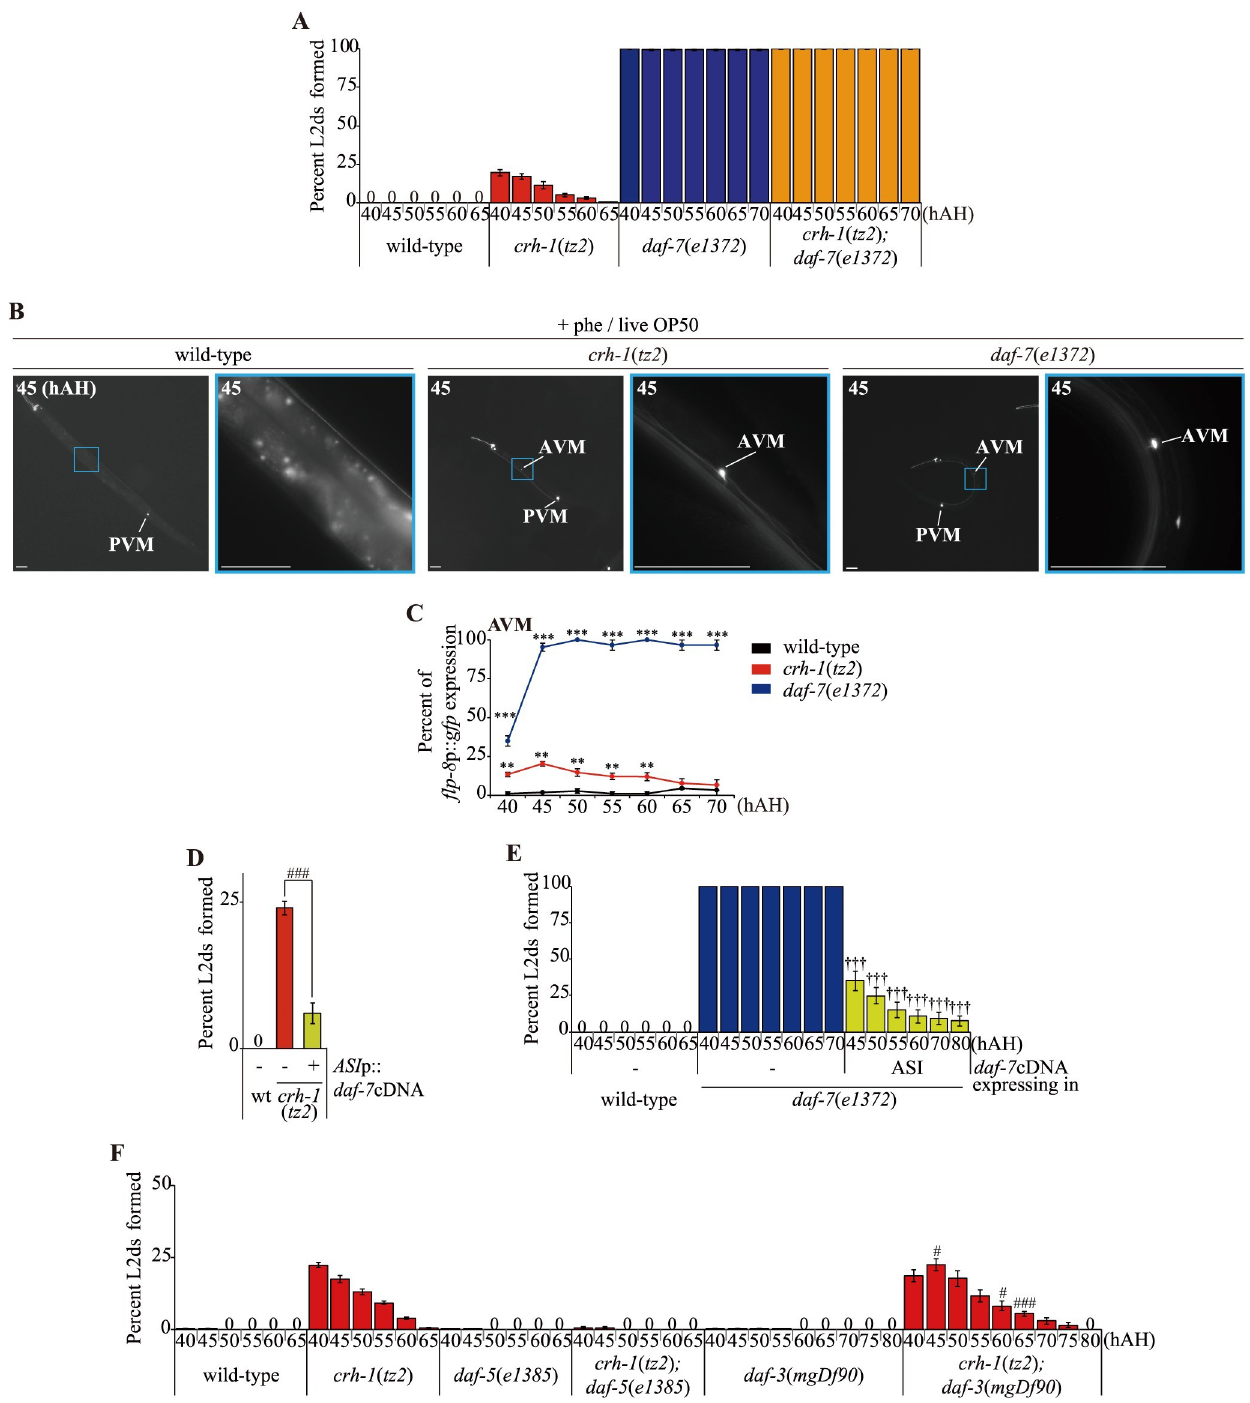
Fig 5. daf-7 mediates the ascr#5-mediated L2d formation of crh-1 mutants. (A) Percent of L2d formed by animals of the indicated genotypes when grown in the presence of live OP50 food and ascr#5 pheromone. N � 4 for each. (B) Representative images of wild-type (left column), crh-1 mutant (middle columns), or daf-7 mutant animals expressing of flp-8 p:: gfp in a subset of touch receptor neurons in the presence of live OP50 food and ascr#5 pheromone. The color-matched boxed regions of the second column each are shown at higher magnification. hAH, hour after hatching. Scale bars: 50 μ m. Images of wild-type and crh-1 mutants are originated from Fig 2B. (C) Percent of flp-8 p:: gfp expression in the AVM neurons by animals of the indicated genotypes when grown in the presence of live OP50 food and ascr#5 pheromone. n � 30 for each. ��� indicates different from wild-type at p < 0.001(student t-test). (C-E) Percent of L2d formed by animals of the indicated genotypes when grown in the presence of live OP50 food and ascr#5 pheromone. N � 8 (C) , 6 (D) , 4 (E) for each. Error bars represent the SEM. ### or ††† indicates different from crh-1 or daf-7 mutants at p < 0.001, respectively (student t-test).